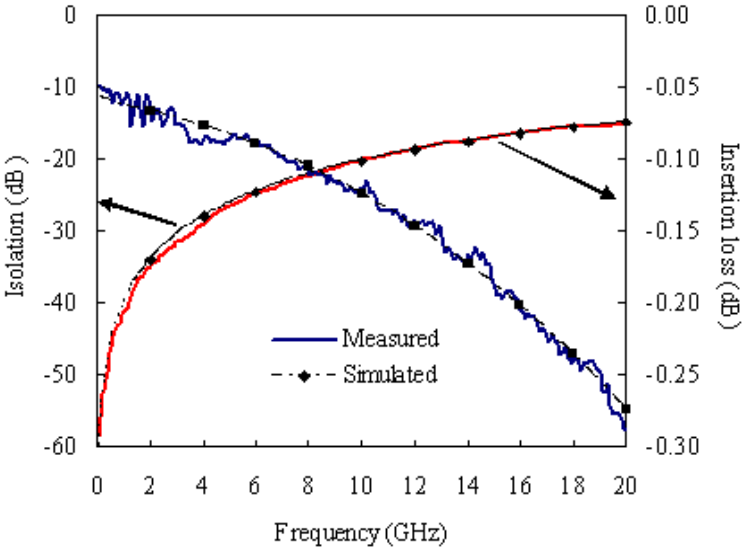
Figure 5. Comparison of the measured and modeled parameters of 3-port MEMS